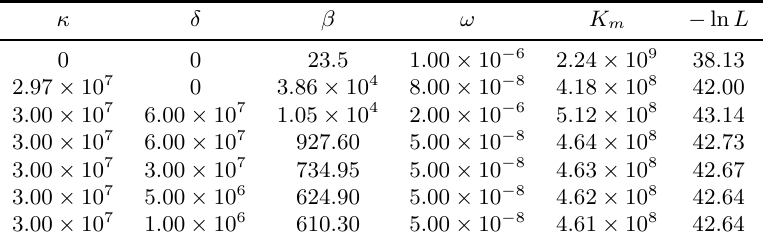
Table 2: The results of the model application on the Cape Rock Lobster with various parameter choices in the model. The parameters κ, δ and ω are chosen while the algorithm searches for K m and β